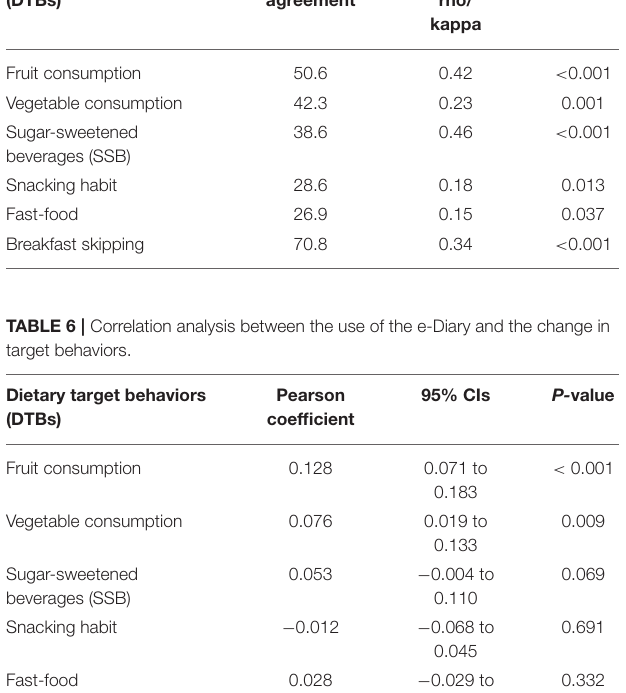
TABLE 5 | Response agreement between the information entered in the e-Diary app and the responses obtained by the KIDMED questionnaire ( N = 189/304). Dietary target behaviors (DTBs)